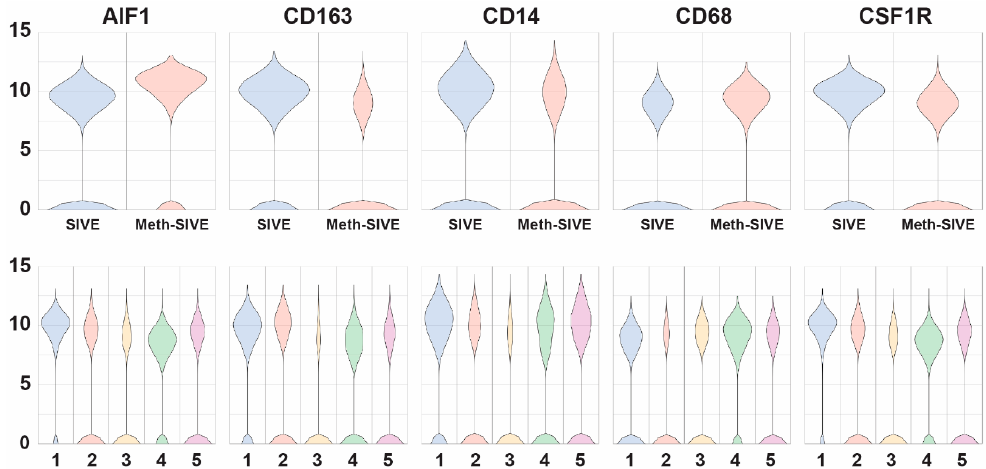
Figure 5. Violin plots showing the relative expression of macrophage/microglia marker genes in the two different conditions (upper) and the five different clusters